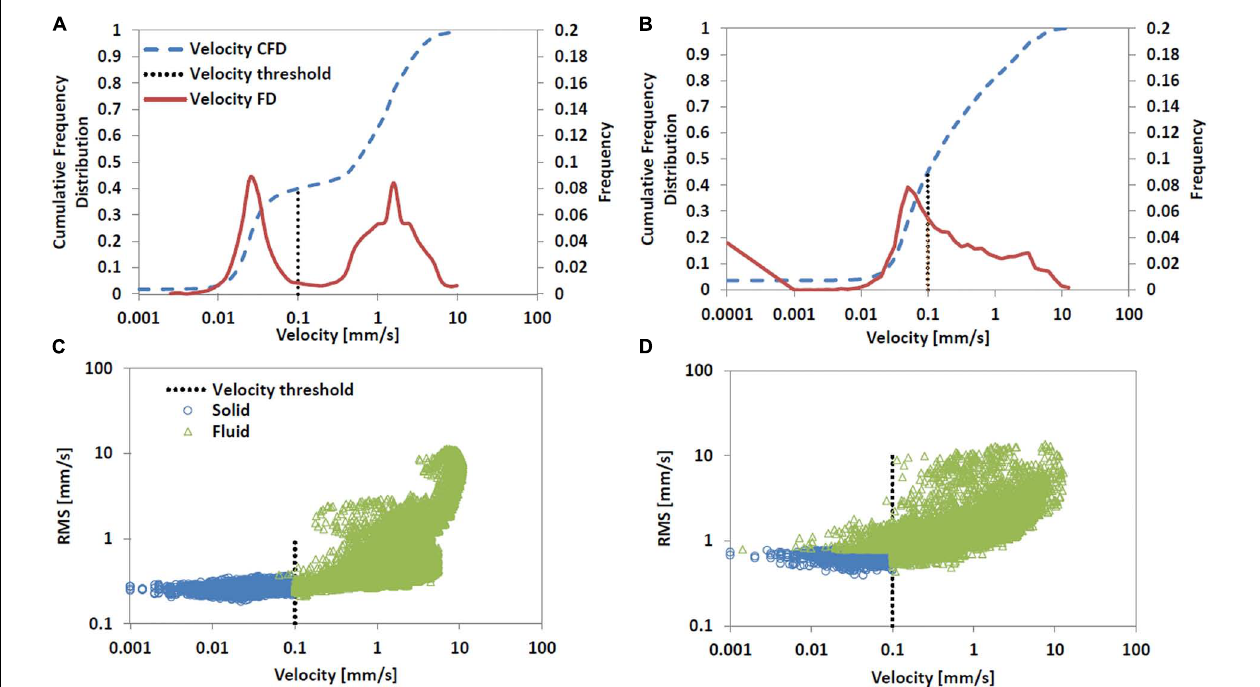
FIGURE 4 | Cumulative frequency distribution, CFD, (dashed lines), and frequency distribution (solid line) of the entire velocity field including solid and fluid are shown in the upper graphs. The root mean square velocity levels (symbols) are shown in the lower graphs with blue points as solid and green points as fluid. Individual grain, mode “a” experiments, left graphs (A,C) ; and packed bed, mode “b” experiments, right graphs (B,D) . The vertical dotted line identifies the velocity threshold of 0.1 mm/s that separates solid from fluid points. For the packed bed shown in (D) , the threshold based on rms (twice the minimum rms, 0.39 mm/s) quantified several slow moving fluid locations that were below the velocity threshold. For the single grain shown in (C) , the threshold based on rms (twice the minimum rms, 0.18 mm/s) quantified very few slow moving fluid locations and only closely adjacent to the velocity threshold.